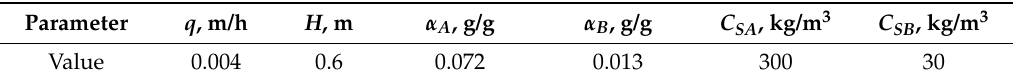
Table 4. Input data for the model simulation.